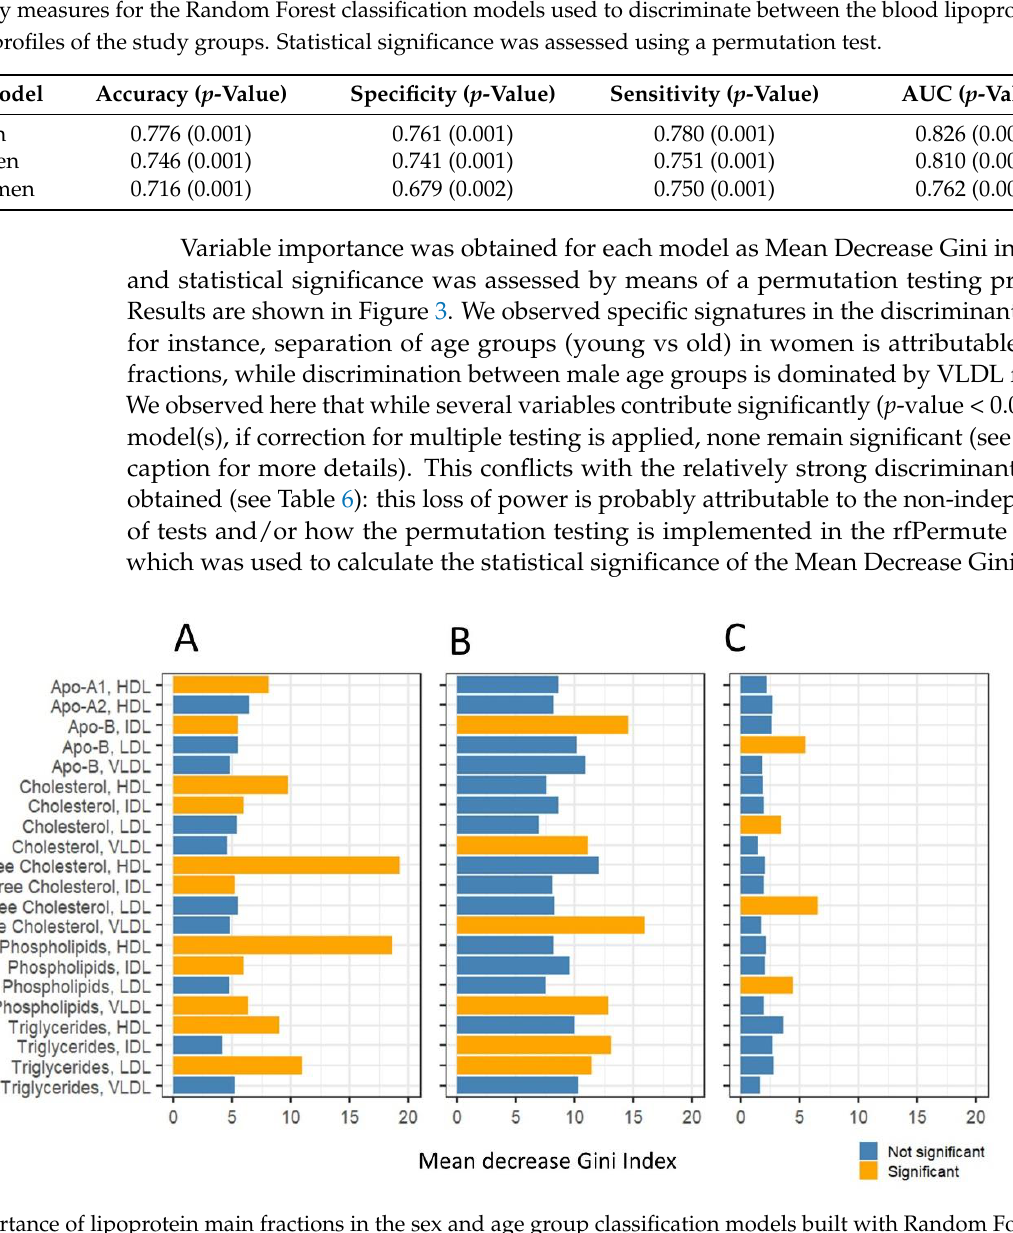
Figure 3. Importance of lipoprotein main fractions in the sex and age group classification models built with Random Forest. ( A ) Men vs women, ( B ) young men vs old men, ( C ) young women vs old women. Variable importance is expressed as Mean Decrease Gini index. Variables with p -value < 0.05 are highlighted in orange. p -values are not corrected (see Results Section 2.2).